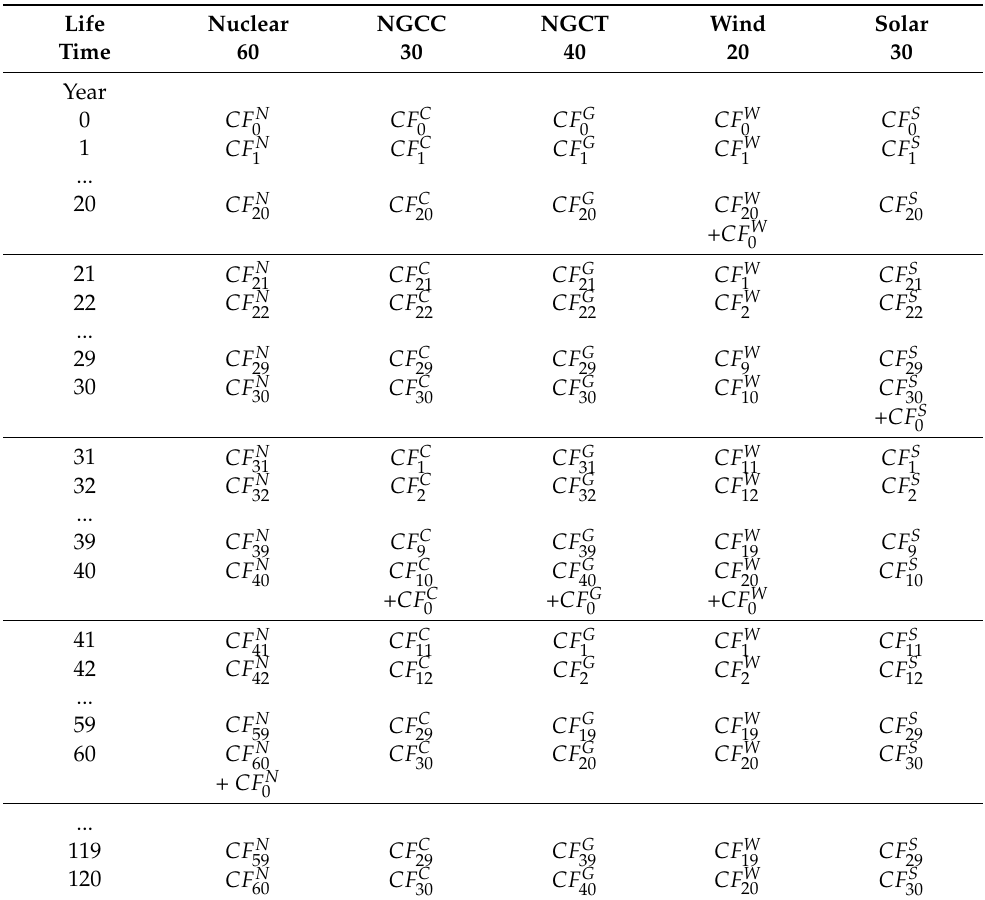
Table 2. Example cash flows for NPV